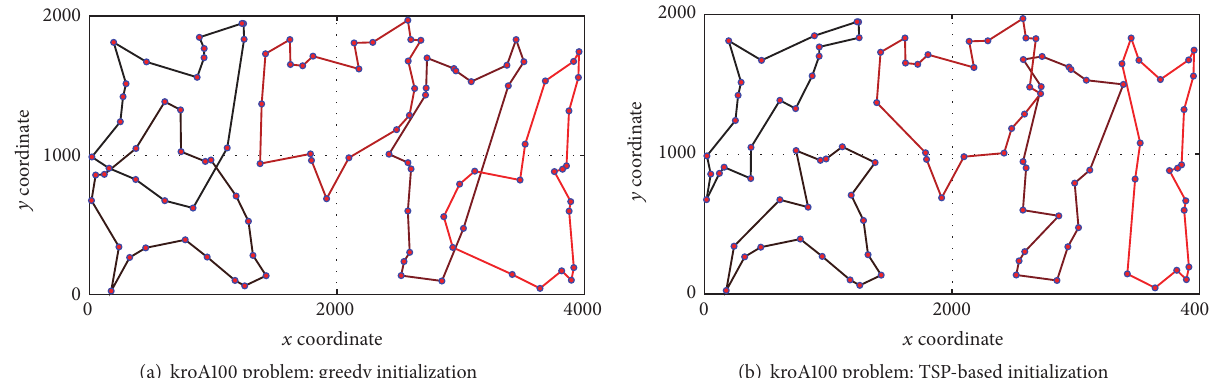
Figure 7: Solving the MTSP by the greedy and the cluster initialization methods. In both cases, 𝑚 = 5 agents are considered, and the target set is kroA100. In (a), the greedy initialization method is used and the final obtained Team Plan is shown. The cost is 4964 , and it is 7.2 % worse than the referenced one. In (b), the TSP-based initialization method is used and the obtained final Team Plan is shown. The cost is 4796 , which is only 3.6 % worse than the referenced one.